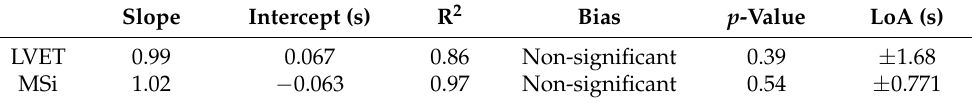
Figure 7. Statistical analyses on inter-breath intervals extracted from FRG and MSi time trends: ( a ) results of linear regression; ( b ) results of Bland–Altman analysis. Table 2. Results of regression, correlation, and Bland–Altman analyses for LVET and MSi trends.